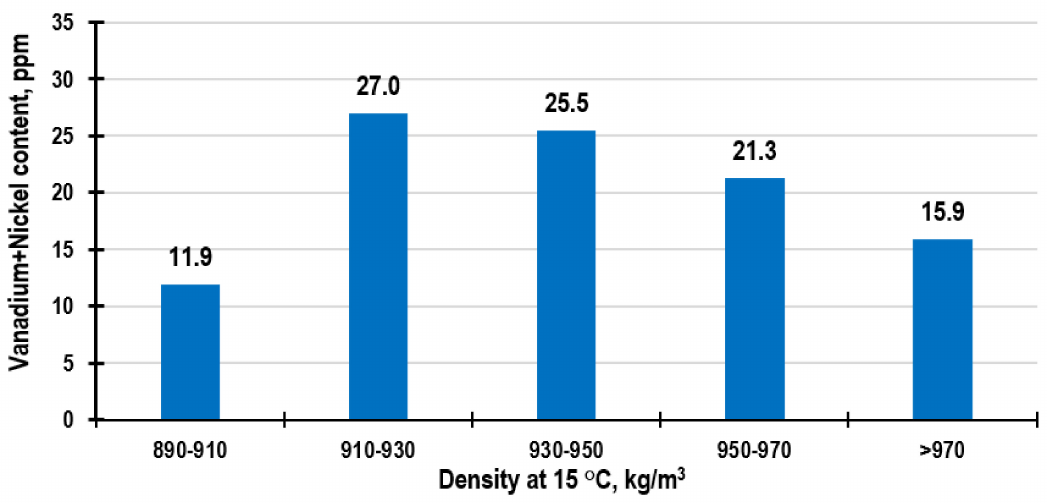
Figure 7. Dependence of the total vanadium and nickel content on the fuel density [50].